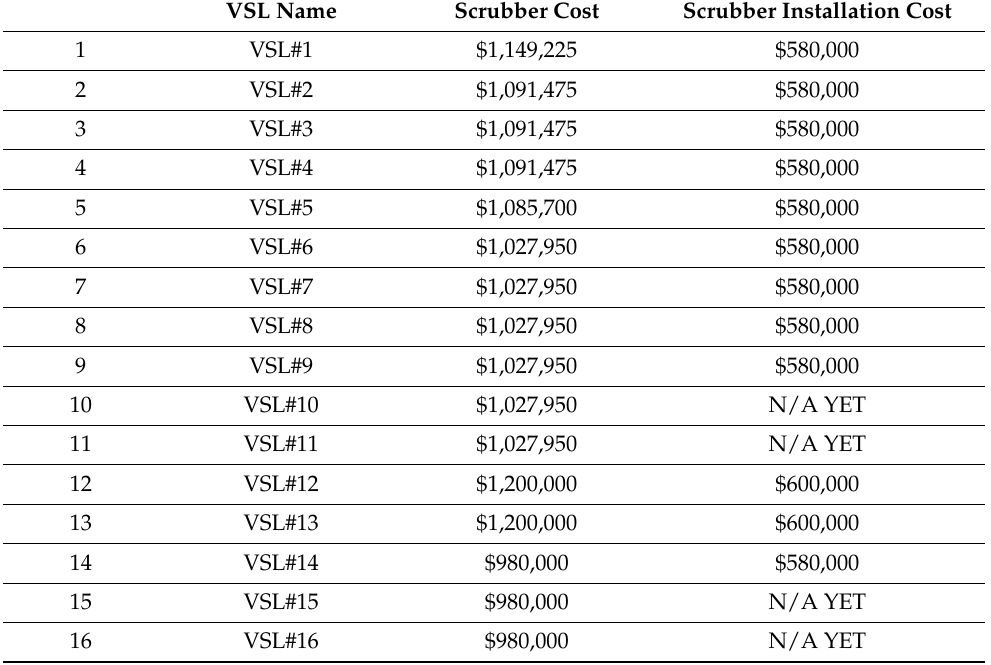
Table 11. Seawater scrubber purchase cost, scrubber maker and scrubber indicative installation cost for 16 different vessels of a Greek maritime company. (Table was generated using data from ref.